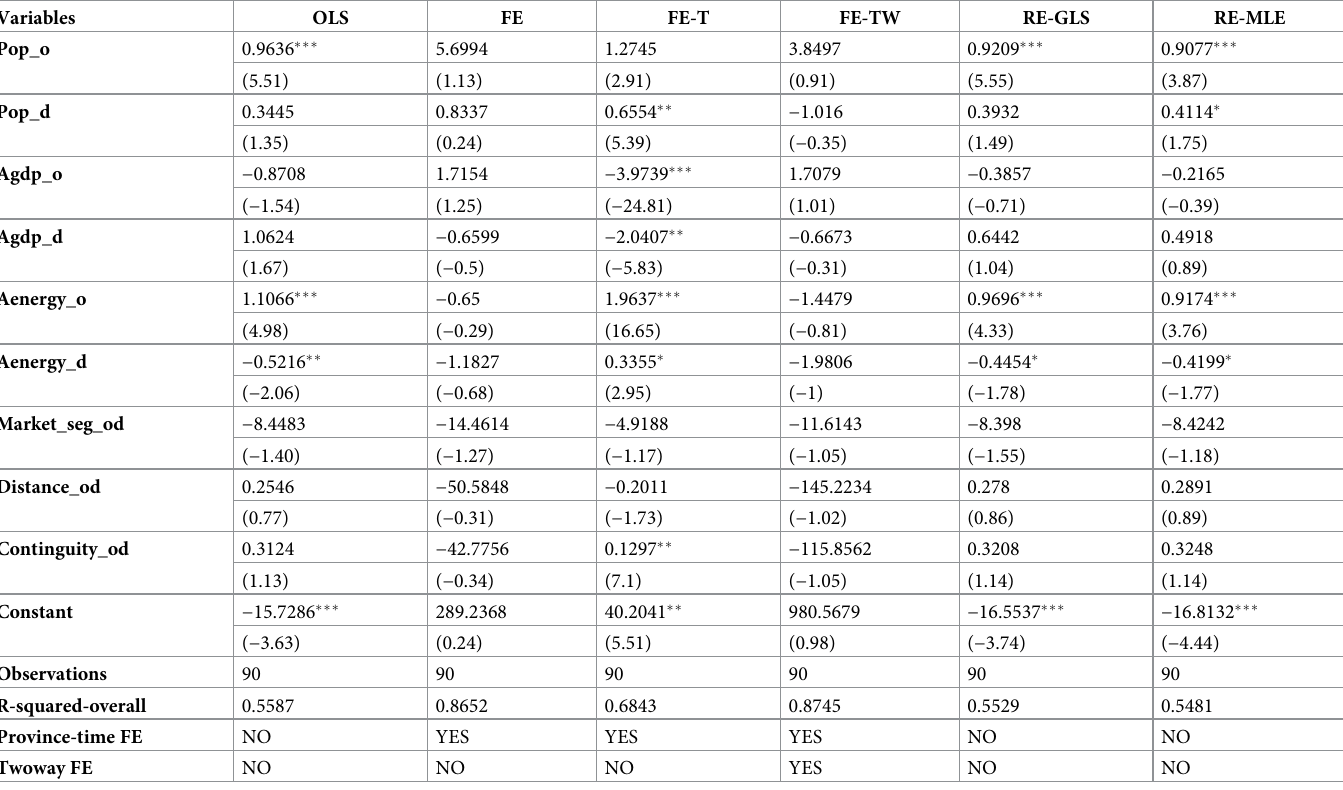
Table 3. The gravity estimated results using interprovincial embodied CO 2 flows within Central China.